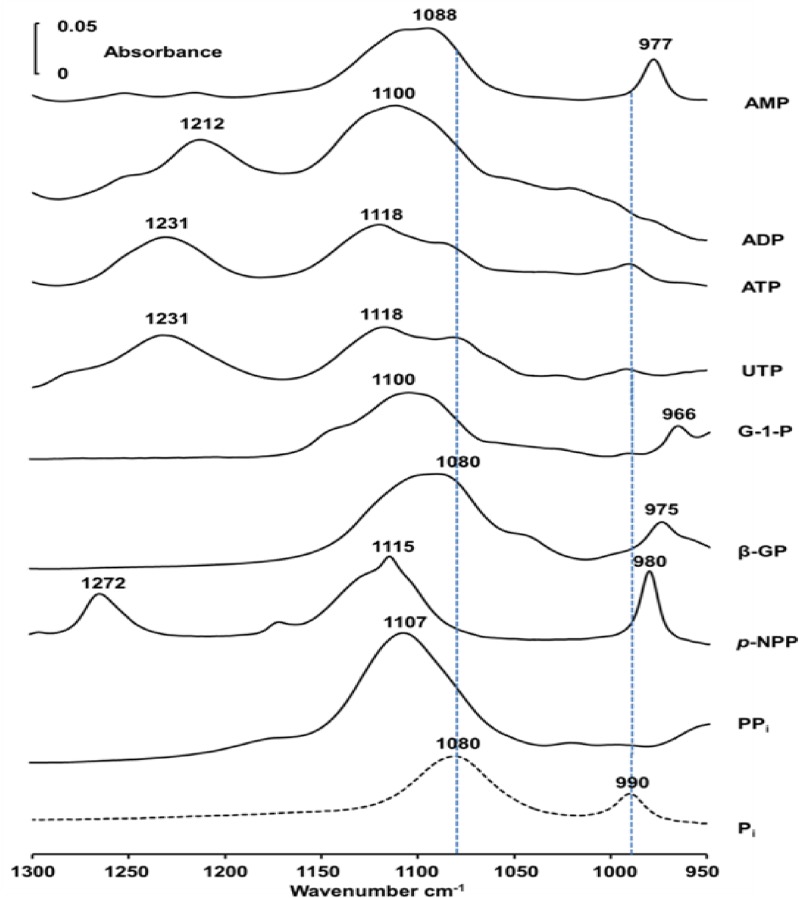
Infrared spectra of substrates.IR spectra of 50 mM phosphatase substrates: AMP, ADP, ATP, UTP, glucose-1-phosphate (G-1P), β-glycerophosphate (β-GP), p-nitrophenylphosphate (p-NPP), PPi and Pi in buffer A (100 mM Tris-HCl pH 8.0, 5 μM ZnCl2 and 5 mM MgCl2) recorded at 37°C.